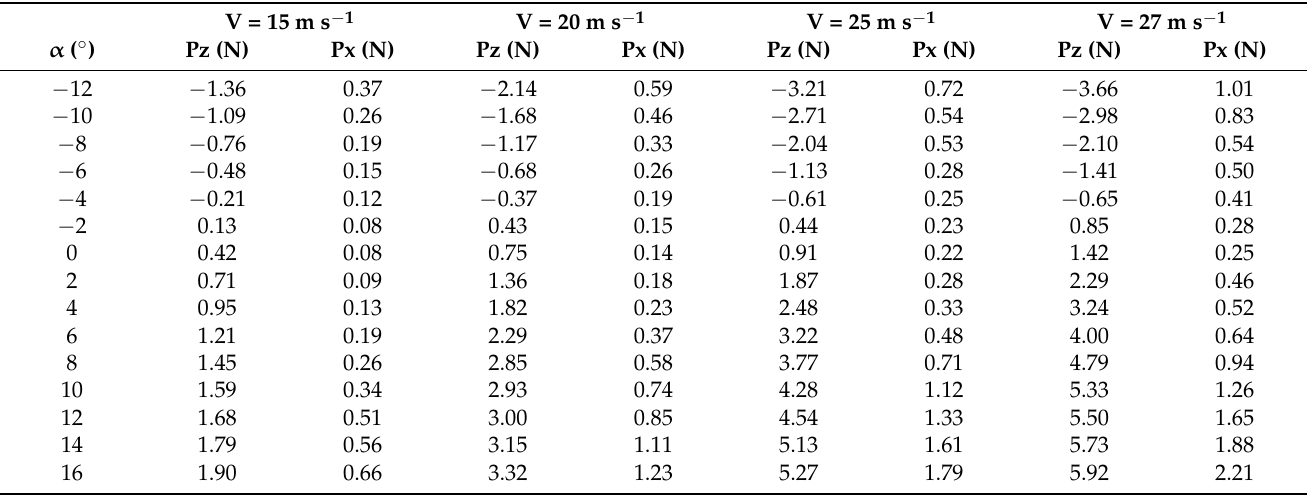
Table 3. Results of measurements of lift force, Pz, and drag force, Px, for positive and negative angles of attack, α , for the given airflow